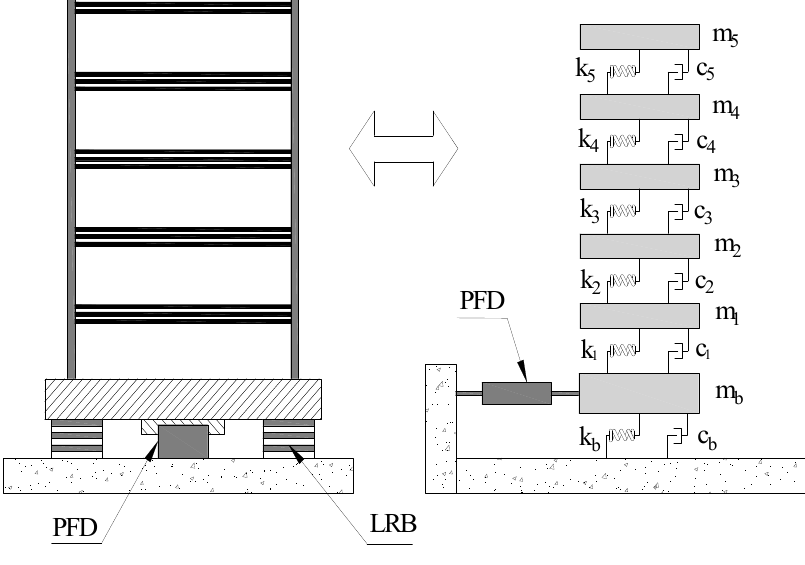
Figure 3. Model of the base ‐ isolated structure.